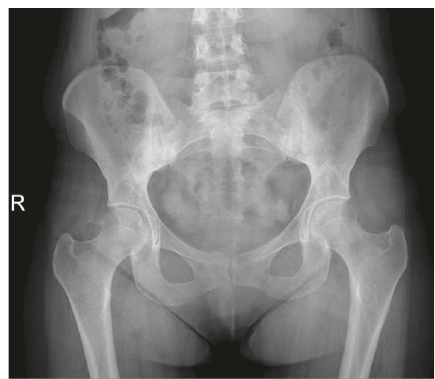
Figure 4: Plain radiograph of the sacroiliac joints demonstrating right grade 3 and left grade 2